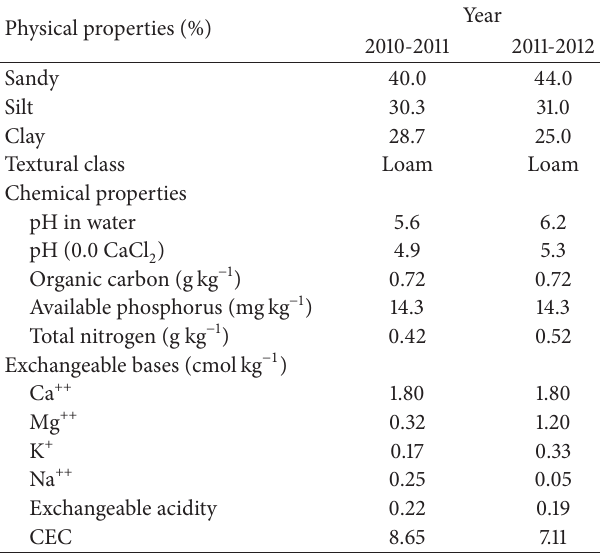
Table 1: Physical and chemical properties of soils at experimental sites in Samaru during 2010-2011 and 2011-2012 dry seasons.